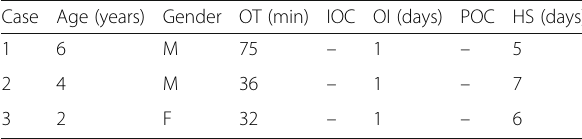
Table 1 The patient demographics and the operative